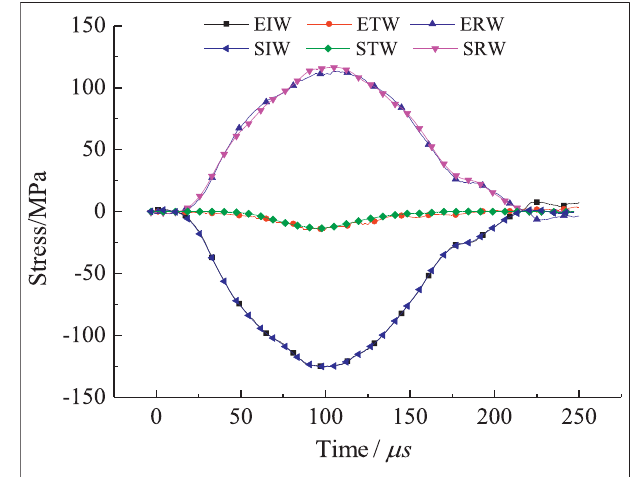
FIGURE 4 | The comparison of waveforms in experiment and simulation. The experimental incident wave (EIW) and the simulated incident wave (SIW) are identical. The experimental re fl ected wave (ERW) and the simulated re fl ected wave (SRW) as well as the experimental transmitted wave (ETW) and the simulated transmitted wave (STW) are also substantially